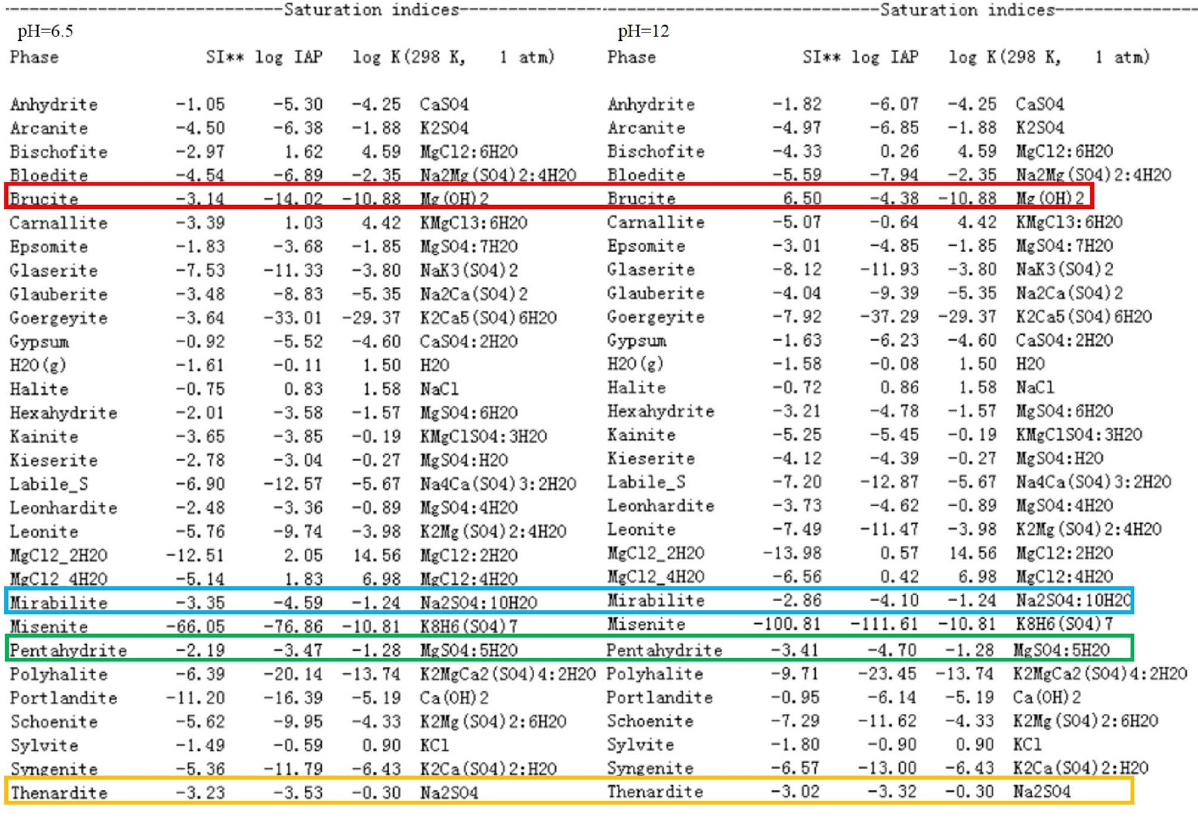
Figure 3. The SI of different minerals under different pH.